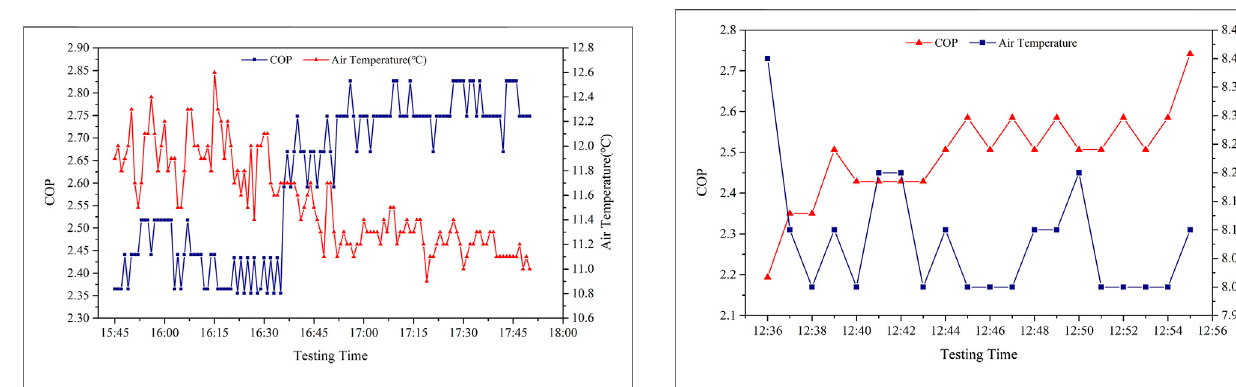
FIGURE 12 | The COP and outdoor air temperature in condition